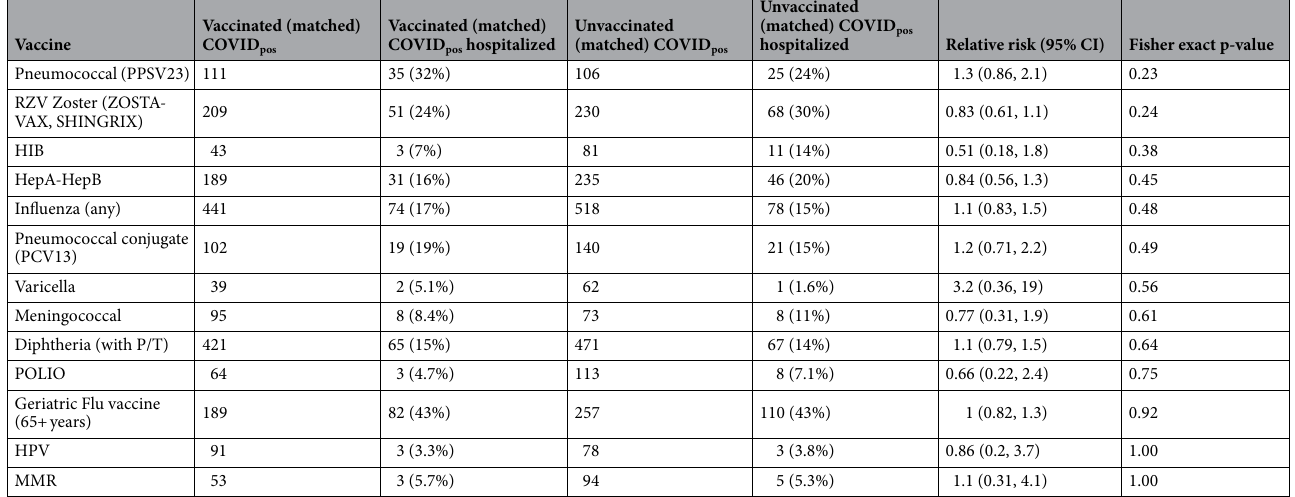
Table 10. Summary of COVID-19 hospitalization rates for vaccinated and unvaccinated propensity score matched cohorts (1 year time horizon). Table of COVID-19 hospitalization rates for vaccinated and unvaccinated (matched) cohorts for vaccines administered within 1 years prior to PCR testing. The columns are (1) Vaccine: Name of the vaccine, (2) Vaccinated (matched) COVIDpos: Number of patients who were COVID-positive among the vaccinated (matched) cohort and had hospitalization status data, (3) Vaccinated (matched) COVIDpos Hospitalized: Number of patients hospitalized for COVID-19 among the vaccinated (matched) cohort, along with the percentage (taken over the vaccinated COVIDpos patients) in parentheses, (4) Unvaccinated (matched) COVIDpos: Number of patients who were COVID-positive among the unvaccinated (matched) cohort and had hospitalization data, (5) Unvaccinated (matched) COVIDpos Hospitalized: Number of patients hospitalized for COVID-19 among the unvaccinated (matched) cohort, along with the percentage (taken over unvaccinated COVIDpos patients) in parentheses, (6) Relative risk (95% CI): Relative risk of COVID-19-related hospitalization in the vaccinated (matched) cohort compared to the unvaccinated (matched) cohort, along with 95% confidence interval in parentheses, (7) Fisher exact